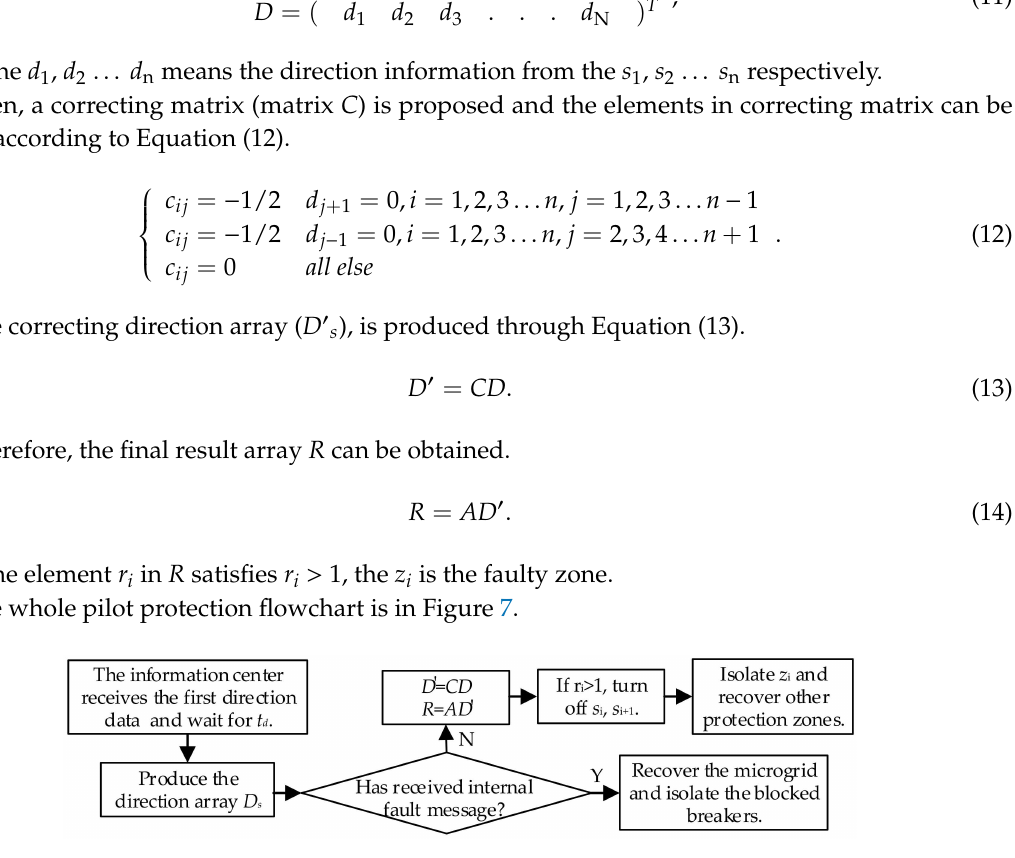
Figure 7. The flowchart of centralized bus pilot protection